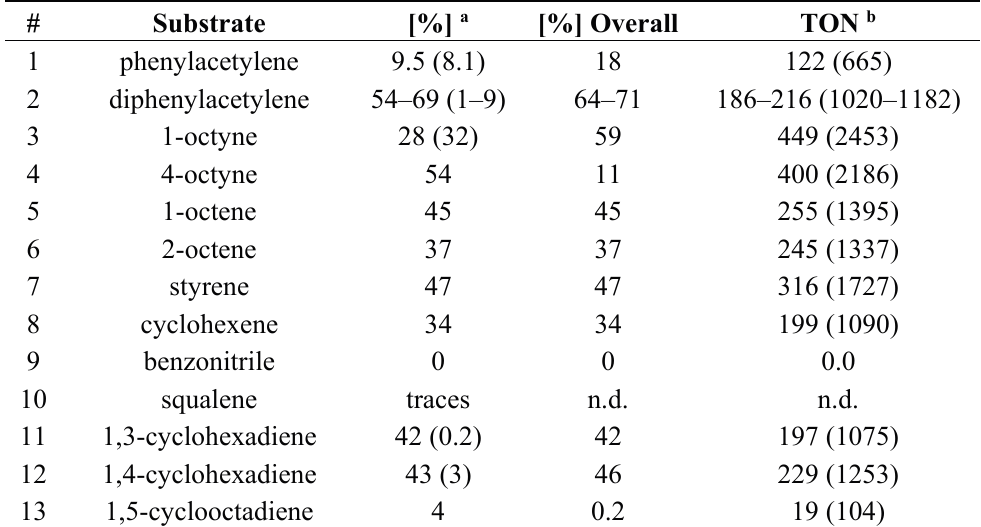
Table 3. Catalyzed transfer hydrogenations with EDAB and Pd@[(BCN)MIM][NTf 2 ] at 70 °C after 18–24